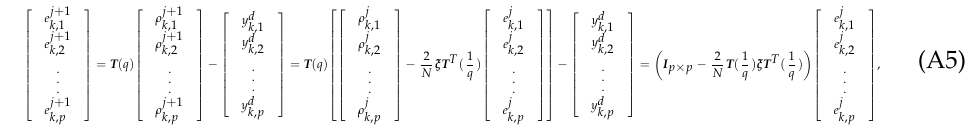
(cid:17) (cid:16) (cid:17) (cid:16) 1 1 (cid:107) T ξ T T are used for the N q q ∞